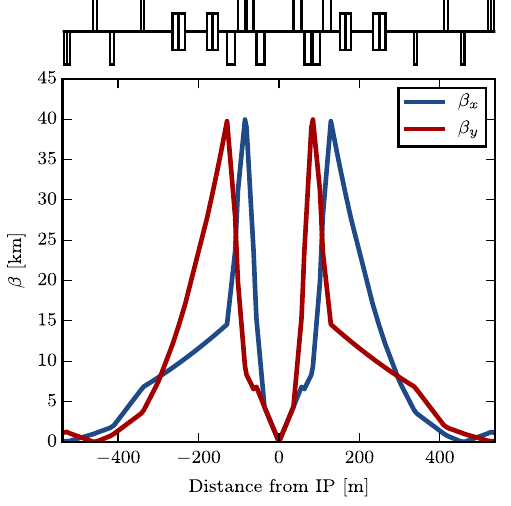
FIG. 6. Interaction region with L (cid:2) ¼ 36 m and β (cid:2) ¼ 0 . 3